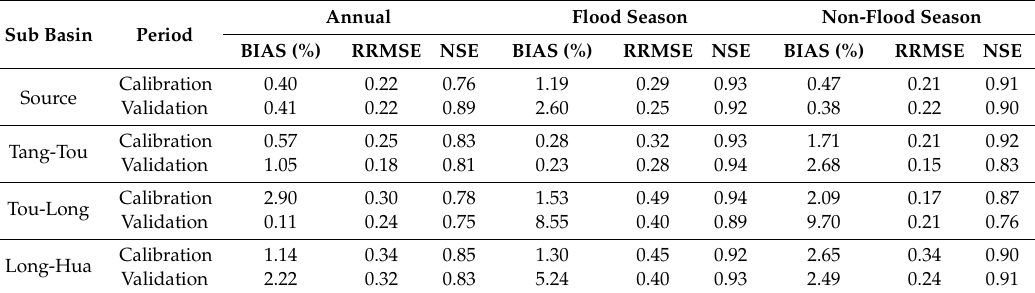
Table 4. Calibration and validation of the annual, flood and nonflood season model in four subregions of the YRB.